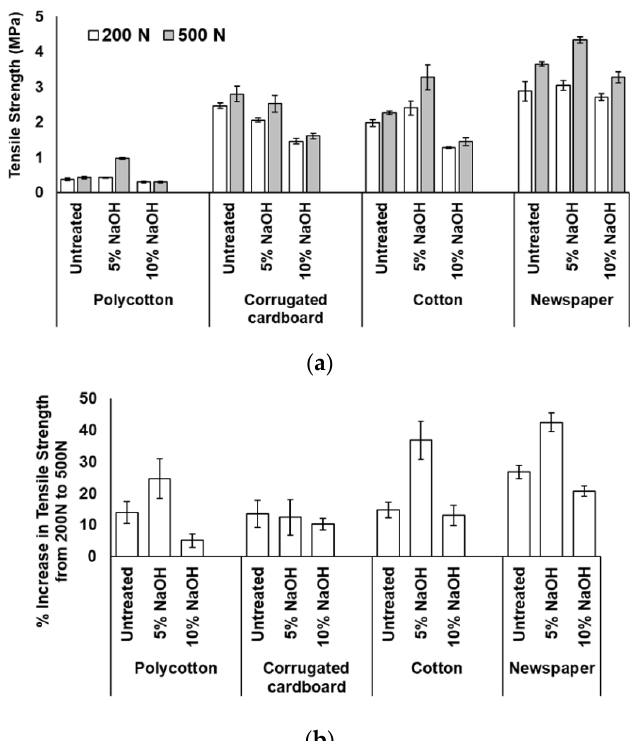
Figure 3. ( a ) Tensile strength and ( b ) percentage increase in tensile strength of compacted sheets at 200 N and 500 N (error bars indicate standard error of the mean).